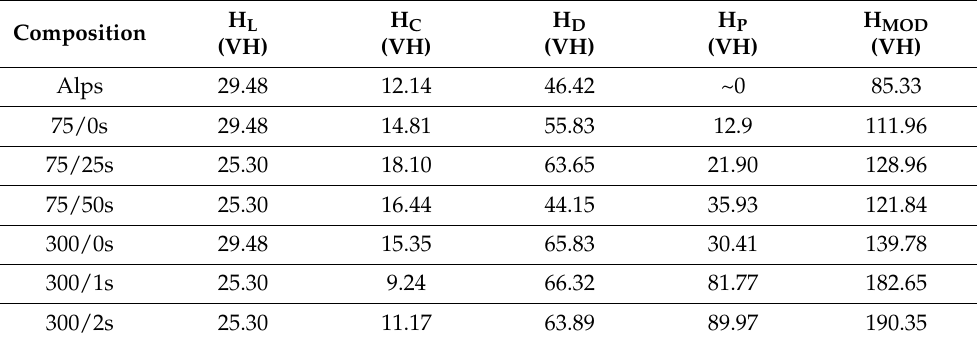
Table 4. H L , H D and H C values and modeled H MOD